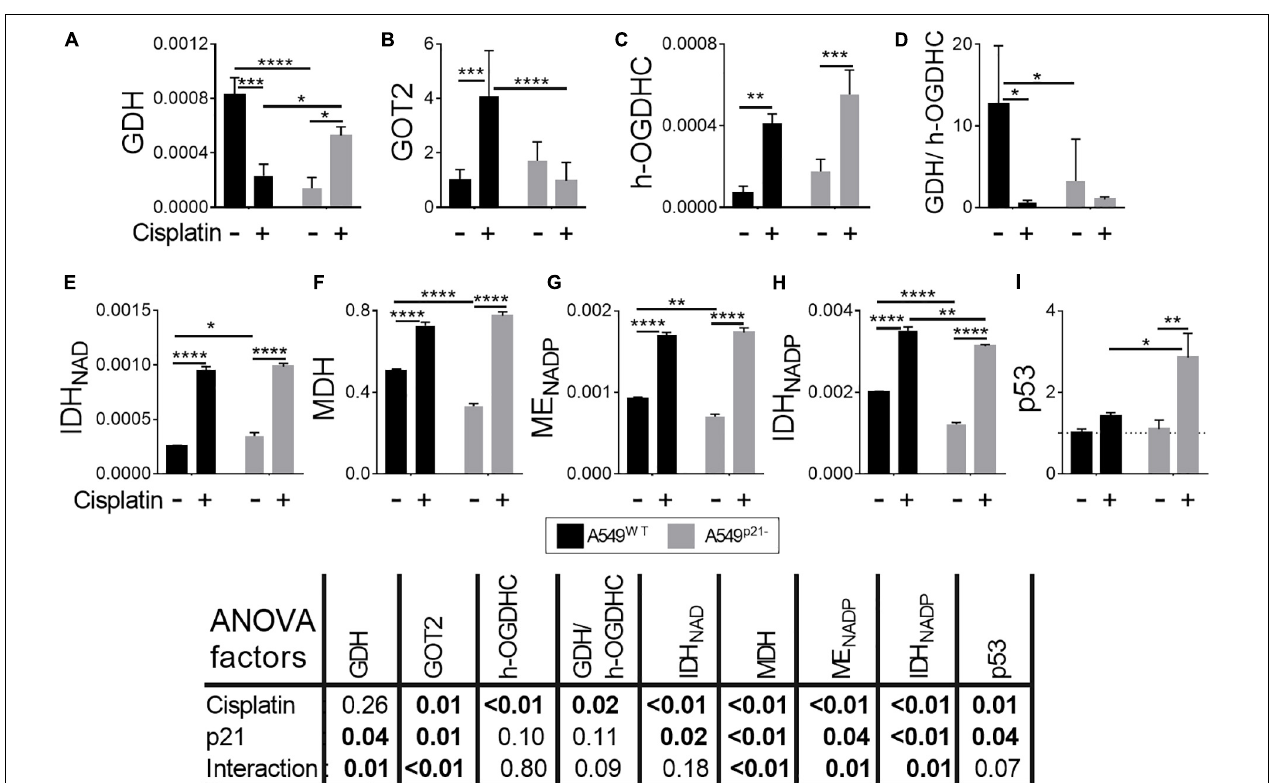
FIGURE 3 | Changes in activities or expression of the enzymes and p53 in A549 WT and A549 p21 − cells induced by cisplatin. (A,C,E–H) Activities of the enzymes indicated on Y axes are shown as µ mol · min − 1 · mg − 1 ; (B) protein level of the mitochondrial aspartate aminotransferase (GOT2), arbitrary units; (D) ratio of activities of GDH to endogenous holo-OGDHC (h-OGDHC), assessing the glutamate degradation in the TCA cycle; (I) protein level of p53, arbitrary units. Where indicated, cells were incubated with 5 µ M cisplatin for 24 h. The data are obtained from three independent cell cultures. Values are presented as mean ± SEM. Statistical significance of the differences is determined by two-way ANOVA followed by Tuckey’s post hoc test. P -values of the significances of the two factors and their interaction, analyzed by ANOVA, are provided in the table under the graphs. On the graphs, different p -values are shown by asterisks as described in Materials and Methods under Statistical Analysis